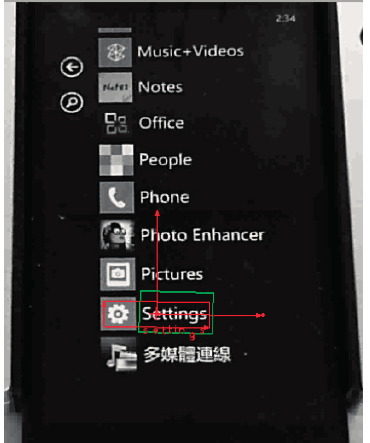
Figure 16. Recognition result with red characters: